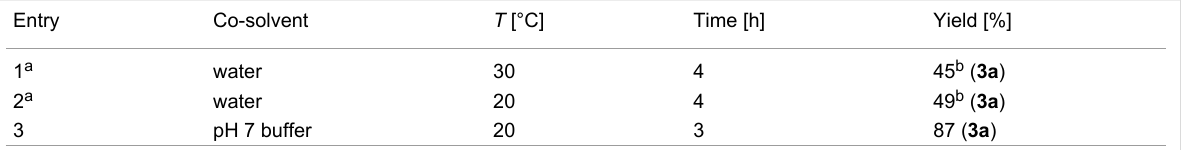
Table 1: Impact of the reaction medium on the photodecarboxylative addition.